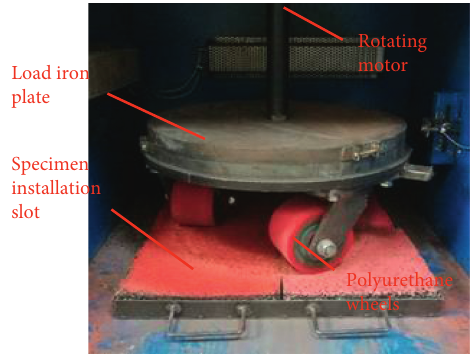
Figure 6: Accelerated wear tester.